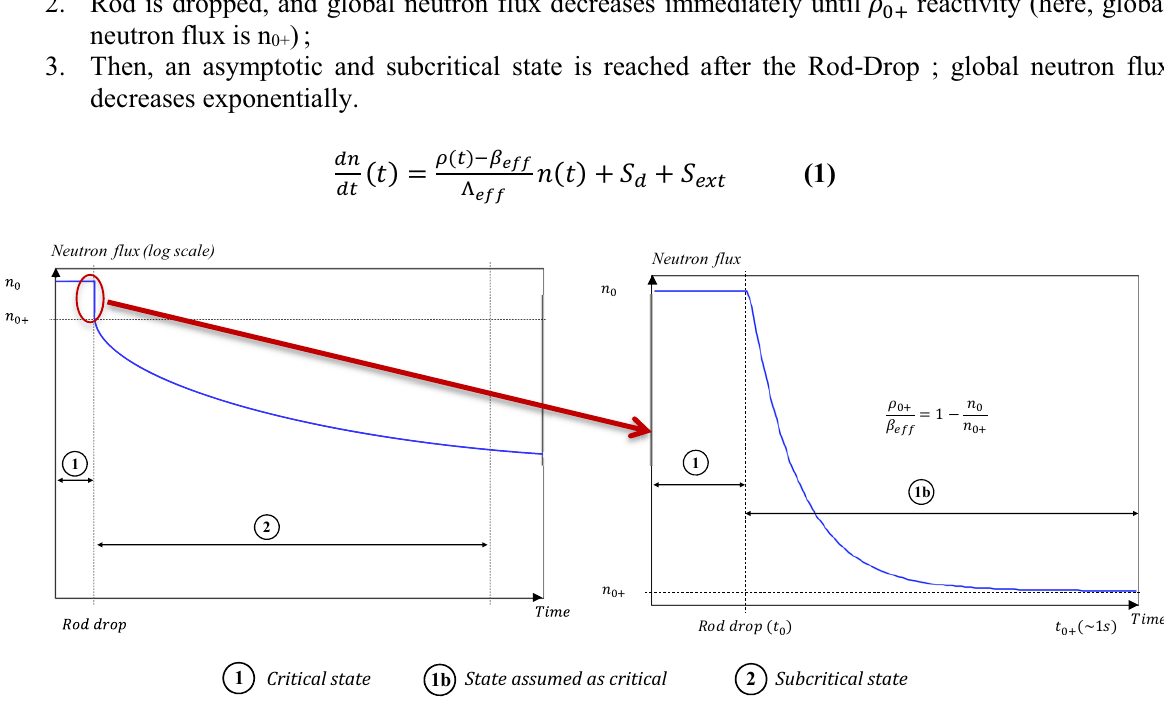
Figure 1 – Schematic representation of neutron flux behavior during rod drop (right =